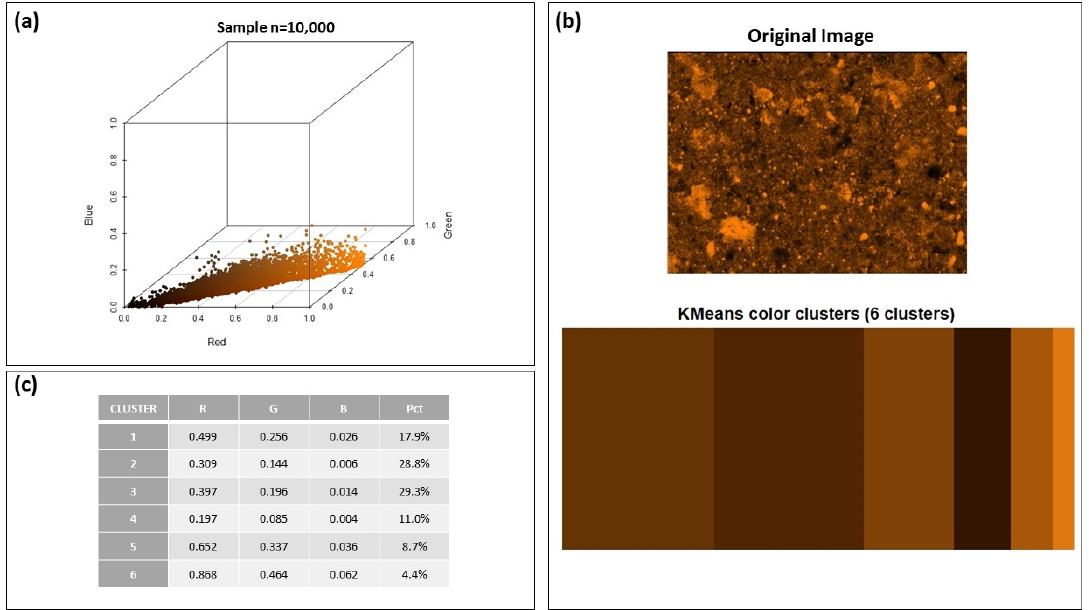
Figure 4. RGB clustering analysis of a µ-XRF 2D map (element: Fe; pellet of a bulk sample). ( a ) RGB counting colours in three dimensions (sample size n = 10,000 pixels); ( b ) Pixel classification in 6 clusters; ( c ) RGB pixel proportions for each cluster.